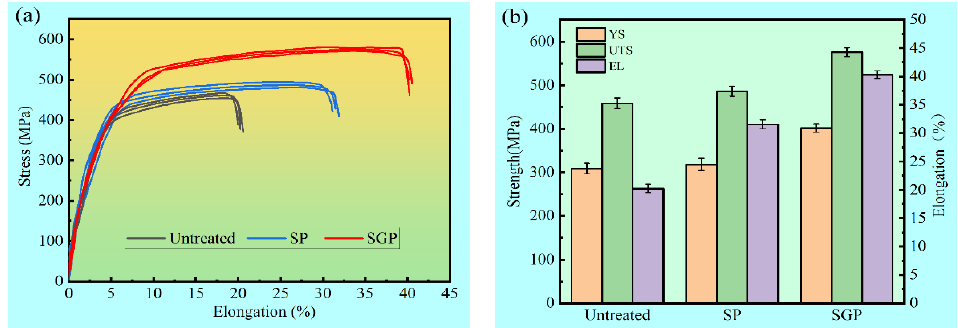
Figure 5. The tensile test results of SGP, SP, and untreated samples: ( a ) the stress–strain curves and ( b ) comparison of YS, UTS, and EL of the samples.